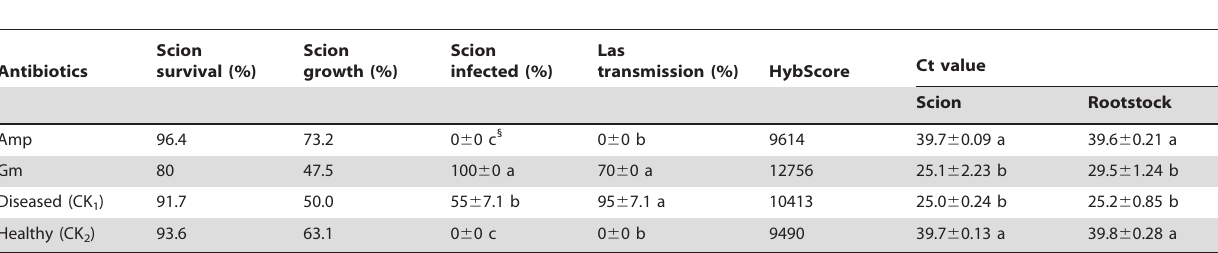
Table 1. Ca. L. asiaticus (Las) and its transmission in grapefruit graft-inoculated with Las-infected lemon scions treated with ampicillin at 1.0 g/L (Amp), gentamicin at 100 mg/L (Gm), or water (disease control, CK 1 ) as well as grafted with the Las-free lemon scions (healthy control, CK 2